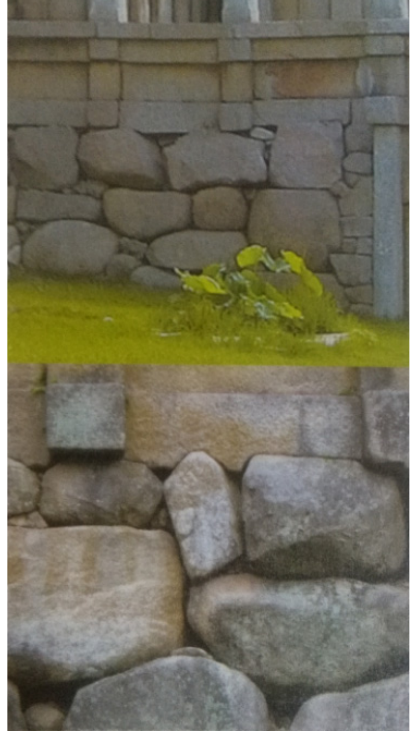
Figure 1. The ‘Grangie’ (‘K ǔ raeng’i’) technique. Source.